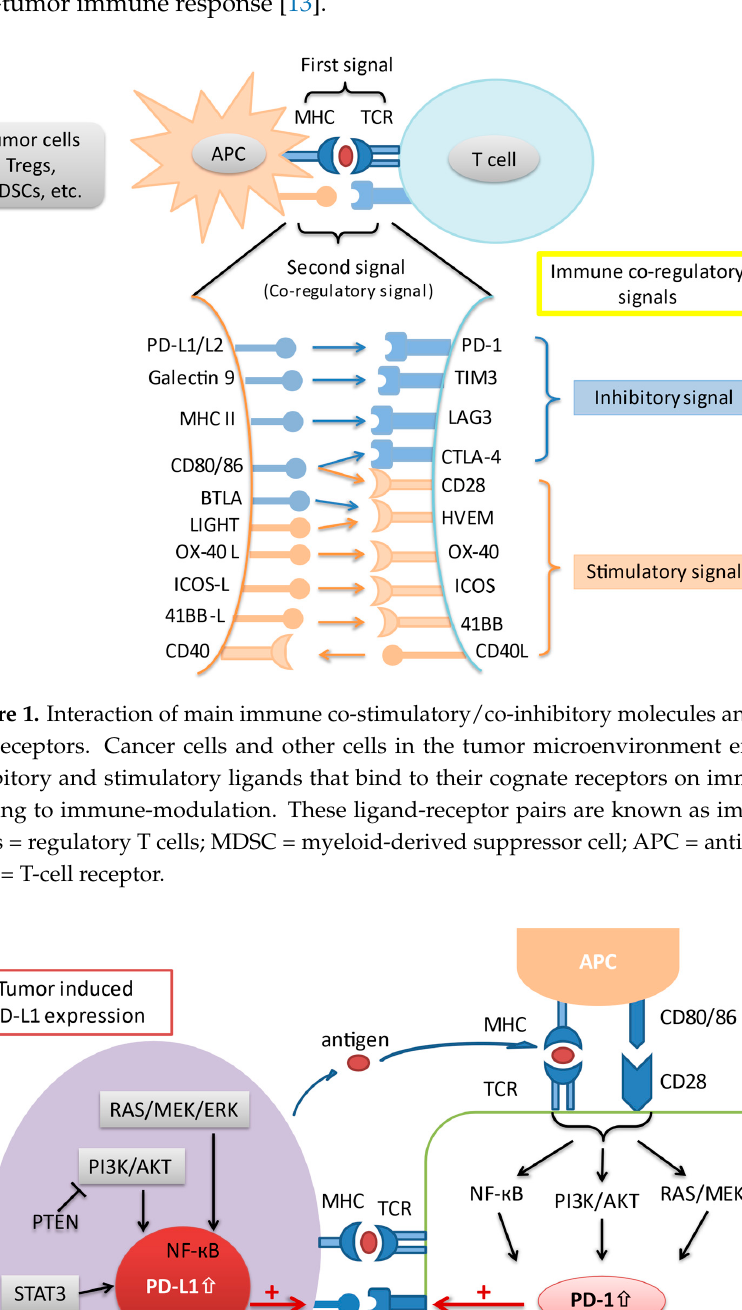
PD-L1 transcription (Figure 2). Anti-PD-1/L1 antibodies block either PD-1 or PD-L1 to increase CD8+ T cell proliferation and partially reverse T cell anergy, resulting in increased anti-tumor immune response [13].